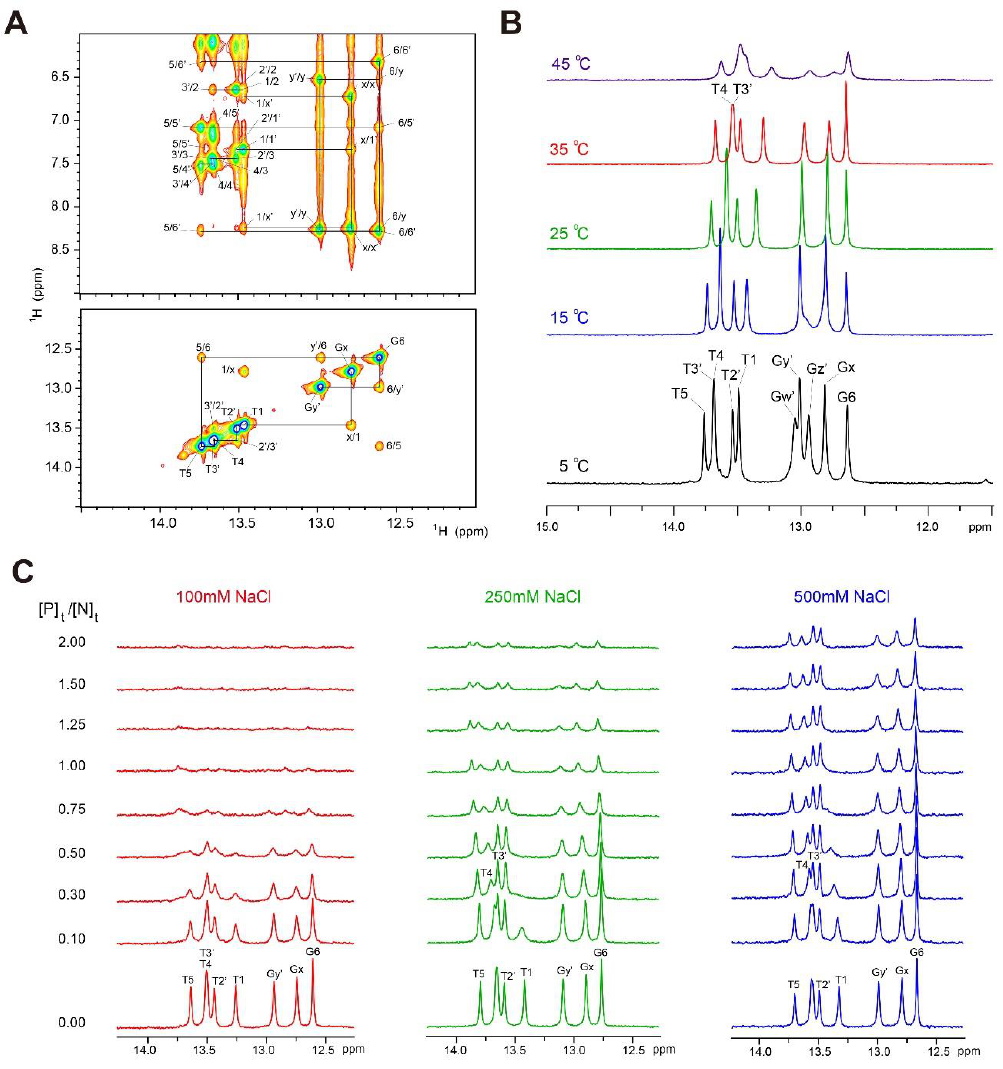
Figure 2. ( A ) Gradient-11-echo NOESY spectra (mixing time = 250 ms) of dlxDNA at 5 °C in 90% H 2 O/10% D 2 O NMR buffer containing 10 mM sodium phosphate (pH = 6.0) and 100 mM NaCl. Solid lines indicate (upper) NOE cross-peaks between imino protons and their own and neighboring H2 or amino protons and (lower) imino-imino connectivities. ( B ) Temperature-dependent 1D imino proton spectra of dlxDNA in NMR buffer. ( C ) The 1D imino proton spectra of dlxDNA at 35 °C upon titration with Dlx3-HD in NMR buffer containing 100 (left), 250 (middle), and 500 mM NaCl (right).